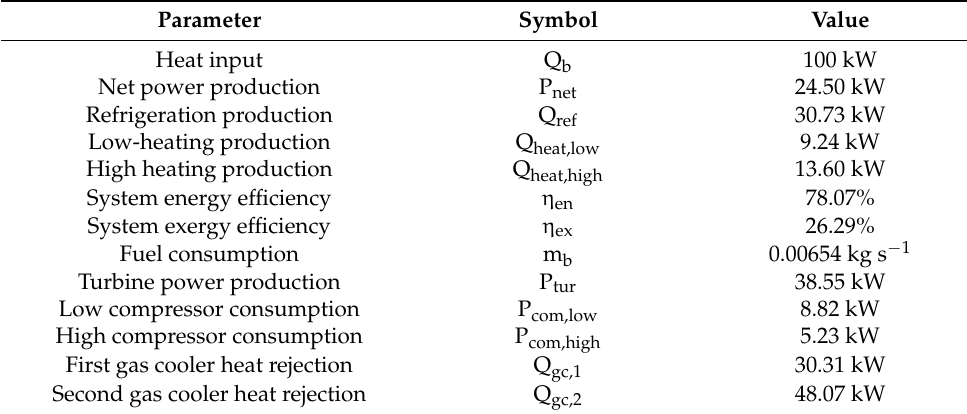
Table 3. Results for the nominal operating conditions.